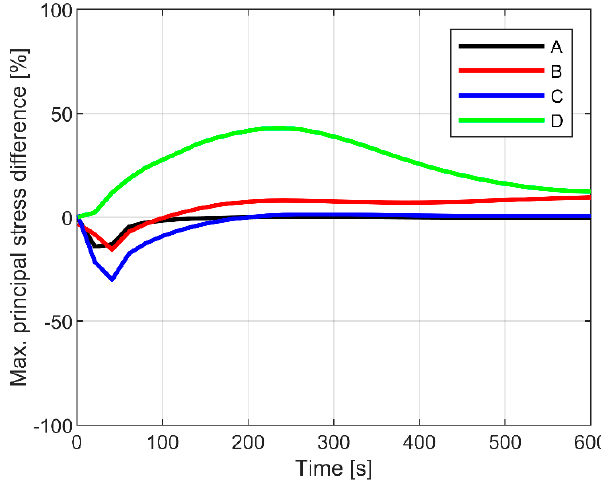
Figure 15. Maximum principal stress sensitivity study at selected control points (ABAQUS/Stand ‐ ard).